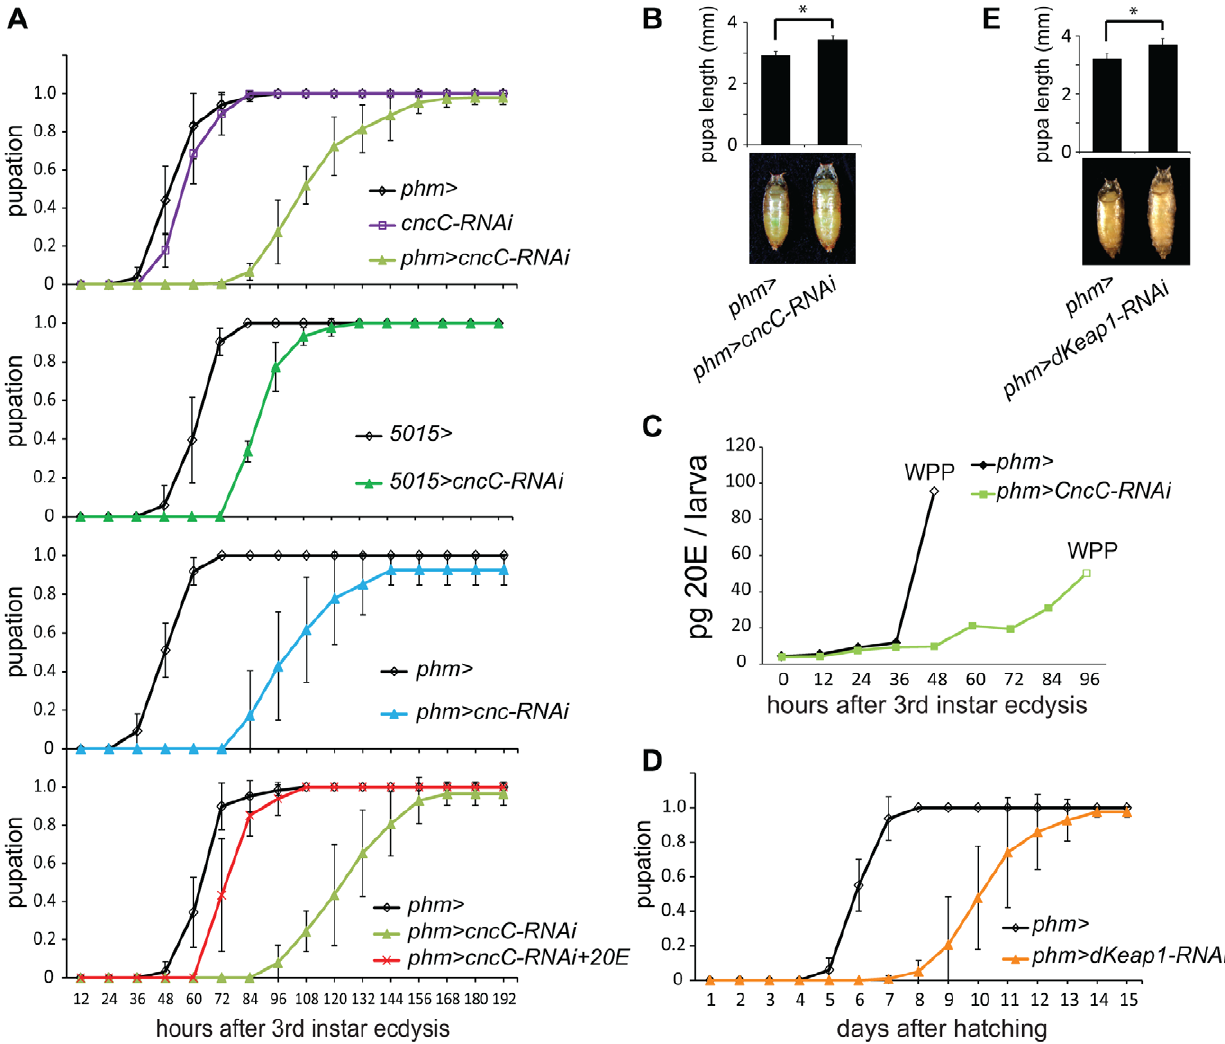
Figure 4. Effects of CncC and dKeap1 depletion on the time of pupation, pupal size, and ecdysteroid levels. (A). Effects of expression of the shRNA targeting CncC in the PG on the time of pupation. The proportion of larvae that had formed pupae was plotted as a function of the time after 3 rd instar ecdysis for control larvae ( phm . or 5015 . , black; cncC-RNAi , purple), for larvae that expressed the shRNA targeting CncC ( phm . cncC- RNAi , green; 5015 . cncC-RNAi , dark green), as well as for larvae that expressed a different shRNA targeting all Cnc isoforms ( phm . cnc-RNAi , cyan) in the PG. Pupation by the larvae the expressed the shRNA targeting CncC was also examined when the food was supplemented with 0.5 mg/ml 20E ( phm . cncC-RNAi + 20E, red). The data in the different graphs were obtained from separate experiments and represent the means and